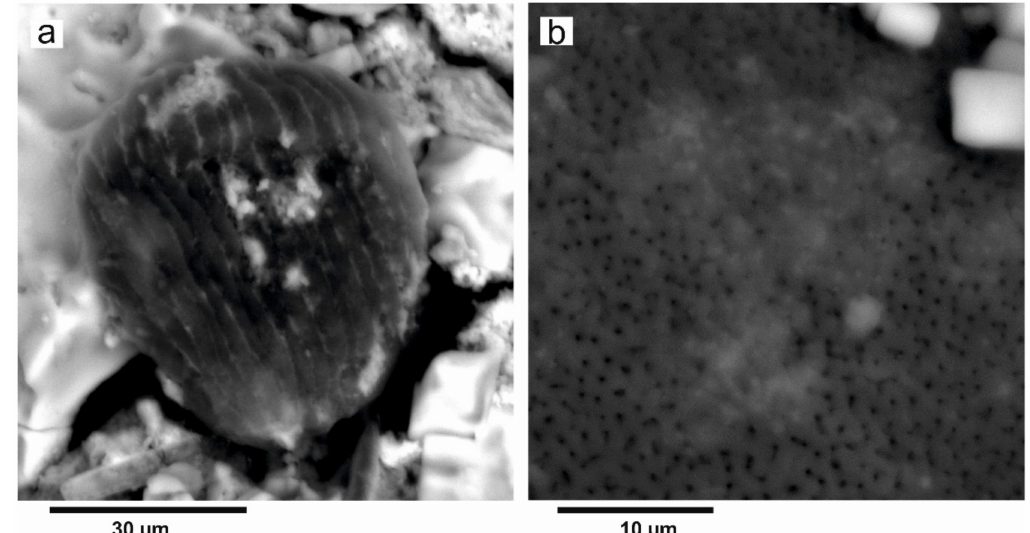
Figure 12. Upper soil horizon (0–3 cm depth) with organic material: ( a ) layered organic formation; ( b ) spongy residue. The lower soil horizon (3–30 cm depth) consists of black gel-like phases with a high content of plant residues. The high concentrations of sulphate in the saline waters (Table 2) and microbiological activities led to hydrogen sulphide formation in this horizon (Figure 5). Content of H 2 S varied from 17 mg/kg, Eh decreased up to − 156– − 197 which corresponded to a reducible condition. Siliceous remains of diatoms, halite, plant residues and iron- bearing phases were found in samples (Figure 13).